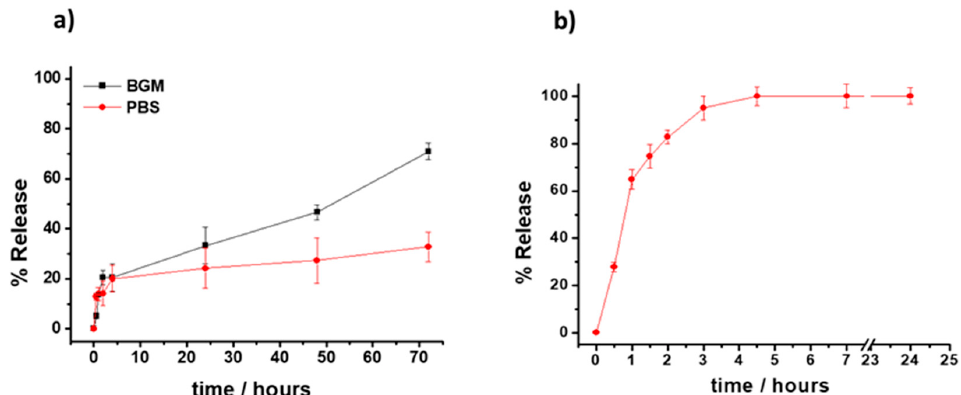
Figure 3. In vitro release profiles: ( a ) NVEs in PBS and BGM at 37 °C; ( b ) HVEs in PBS at 37 °C.